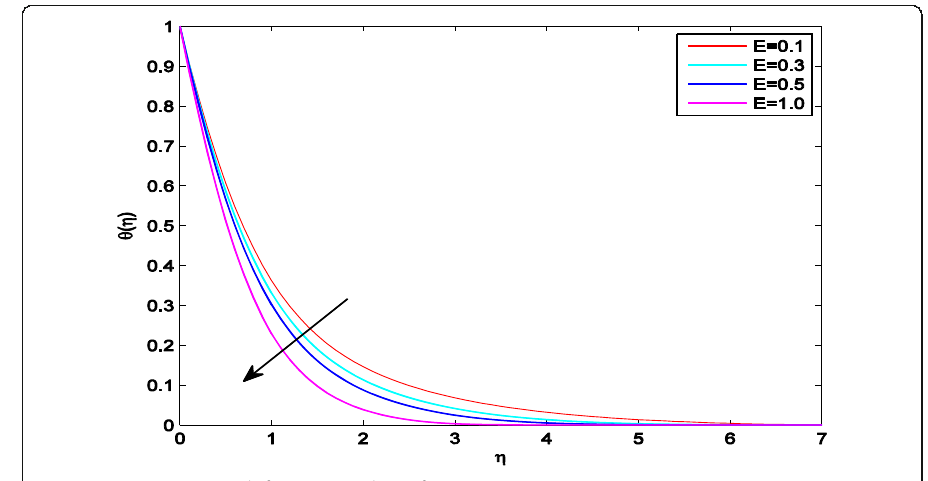
Fig. 20. From the graph, it is possible to observe that as the values of thermal radiation parameter upsurge, the temperature graph and the temperature boundary layer thick- ness are snowballing.